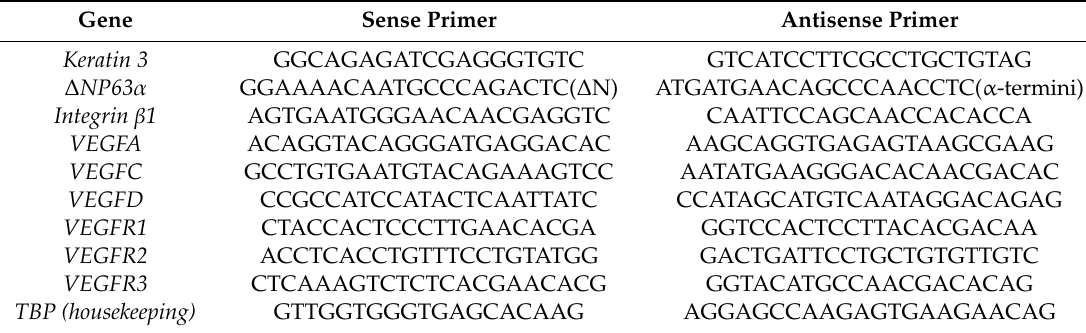
Table 1. Primer Sequences used for RT-PCR